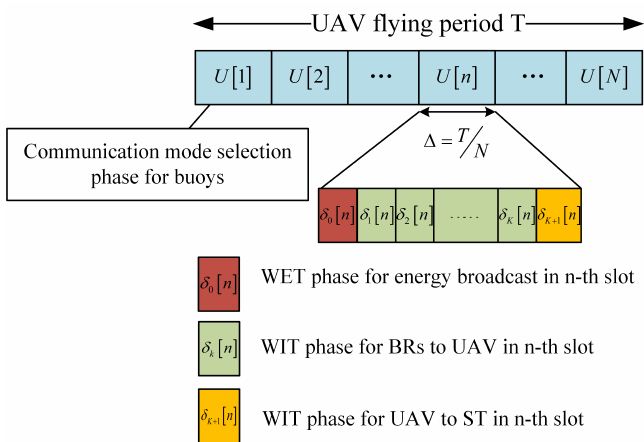
Figure 3. Communication protocol for the U-WPCN relay